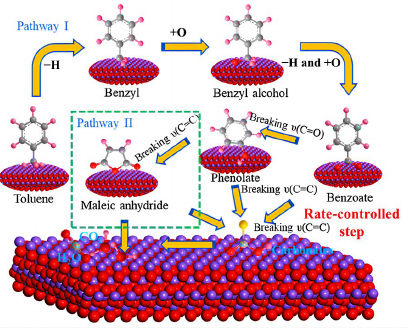
Figure 4. Proposed mechanism for toluene oxidation on a manganese-based catalyst. Reproduced with permission from Ref. [70]. Copyright 2020, Elsevier B.V.